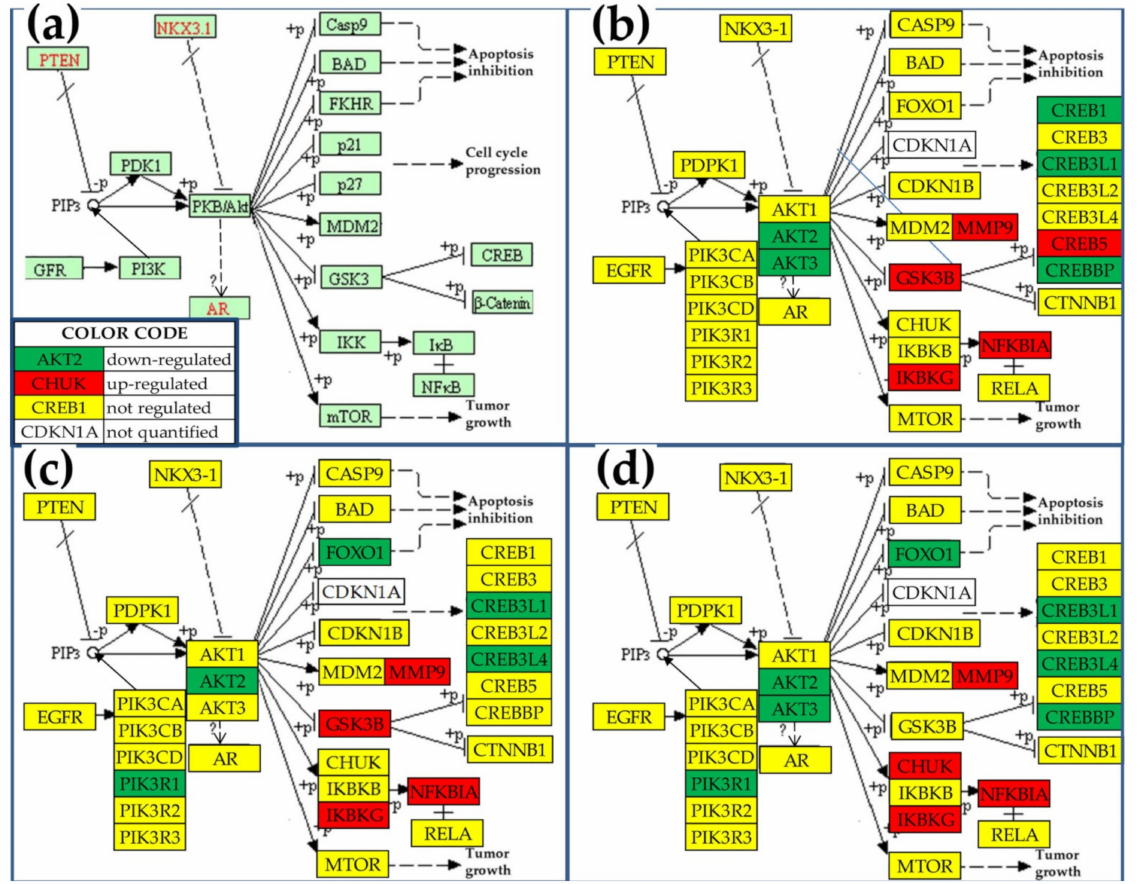
Figure 4. Significantly regulated genes central to the ( a ) KEGG-determined prostate cancer functional pathway in the: ( b ) nodule “A”, ( c ), nodule “B”, ( d ) nodule “C” with respect to the surrounding normal tissue (“N”). Regulated genes: AKT2/3 (v-akt murine thymoma viral oncogene homolog 2/3), CREB1/5 (cAMP-responsive element-binding protein 1/5), CREB3L1/4 (cAMP-responsive element-binding protein 3-like 1/4), CREBBP (CREB binding protein), FOXO1 (forkhead box O1), GSK3B (glycogen synthase kinase 3 beta), IKBKG (inhibitor of kappa light polypeptide gene enhancer in B-cells, kinase gamma), MMP9 (matrix metallopeptidase 9 (gelatinase B)), NFKBIA (nuclear factor of kappa light polypeptide gene enhancer in B-cells inhibitor, alpha), PIK3R1 (phosphoinositide-3-kinase, regulatory subunit 1 (alpha)). (modified from